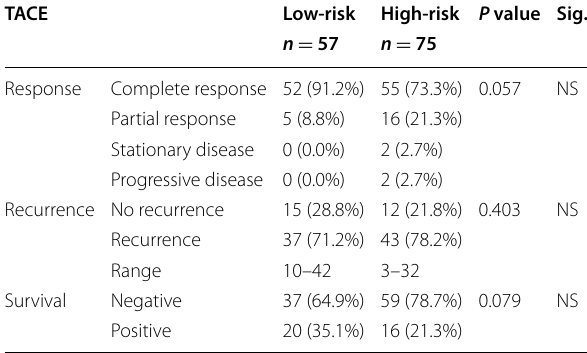
NS Nonsignificant